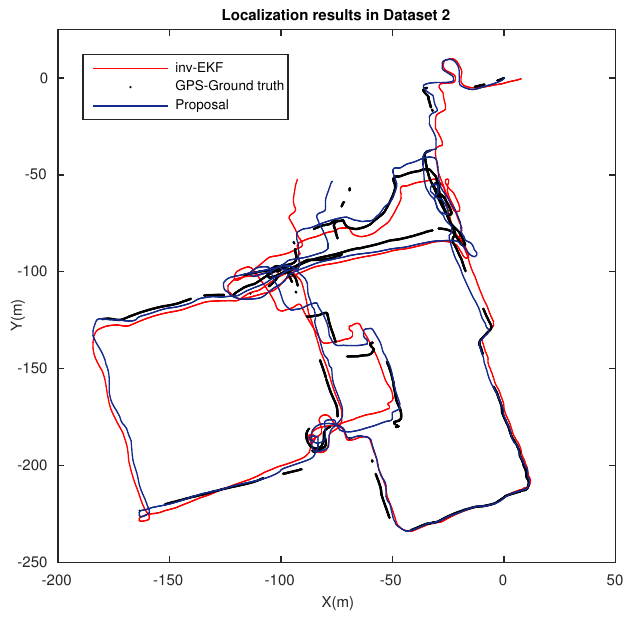
Figure 15. Localization results in Dataset 2, Bovisa 10-04-2008 . Localization estimation obtained with ground truth (GPS) (black), inverse EKF (red), and the proposed matching